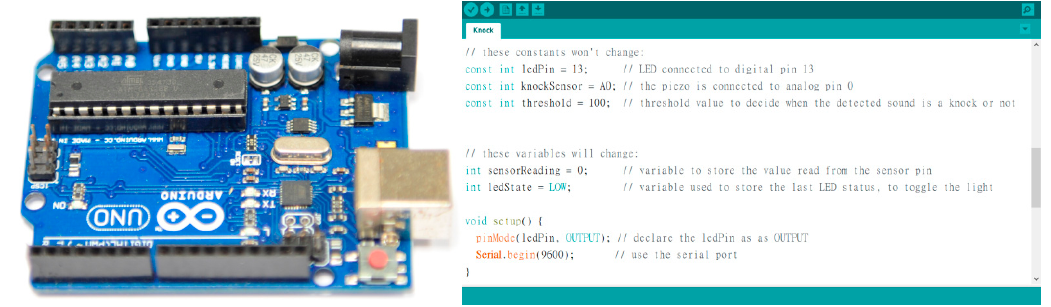
Figure 1. Arduino Uno control board and the screenshot of the editing software.